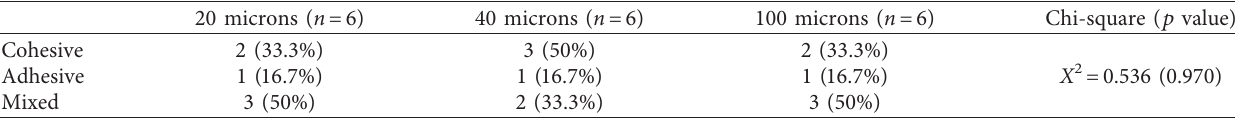
Table 2: Distribution of failure mode in µ SBS among the study